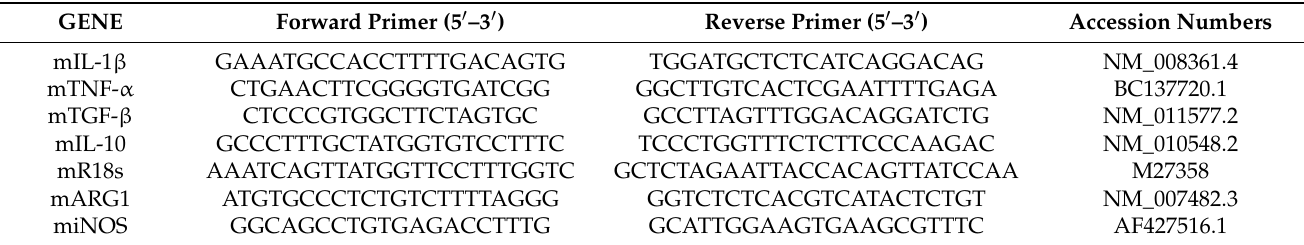
Table 1. List of primer couples generated for